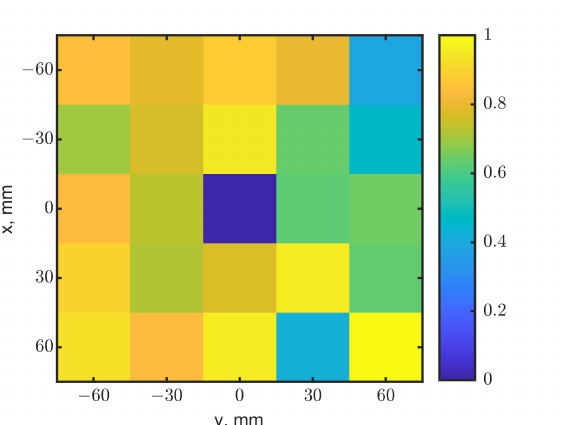
Figure 18. Heatmap by the tuned phased loop array. The tumor was placed at (0, 0) with a depth of 50 mm and had a size of 17.1 3 mm 3 . The dark-blue pixel indicates the tumor’s location.